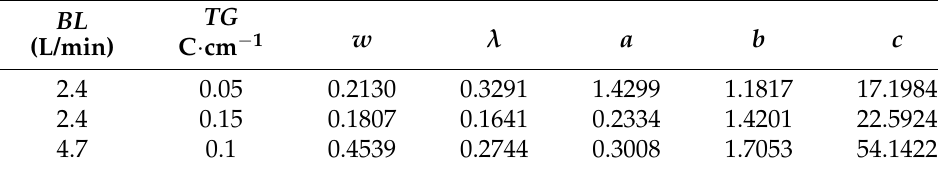
Table 1. EGG parameters for temperature gradient water [5].